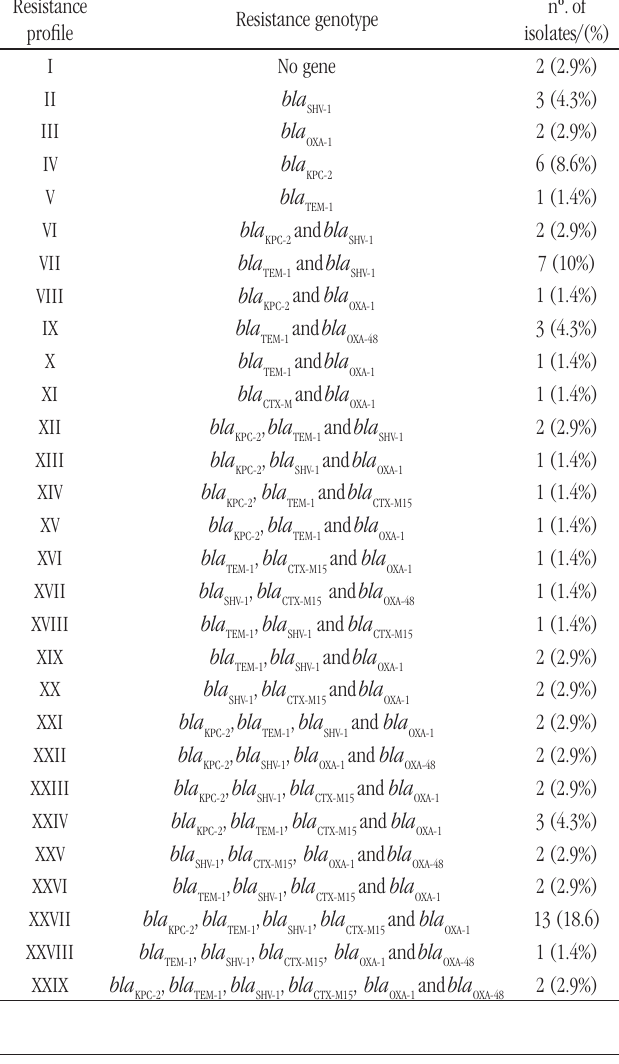
taBLE 2 − Resistance profile of K. pneumoniae isolates according to the detected genes Resistance